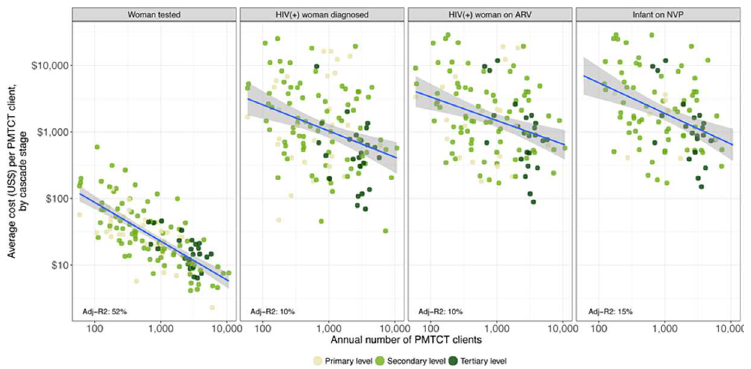
Fig 6. Relationship between PMTCT unit cost and scale, by cascade